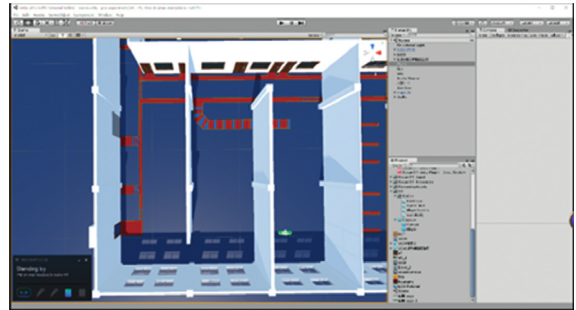
Figure 3: Adaptive environment scenario.